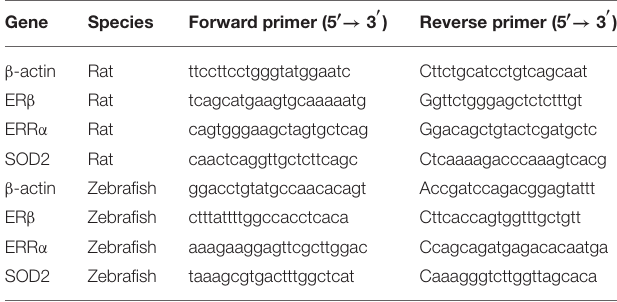
TABLE 1 | Sequences of primers for the real time quantitative PCR